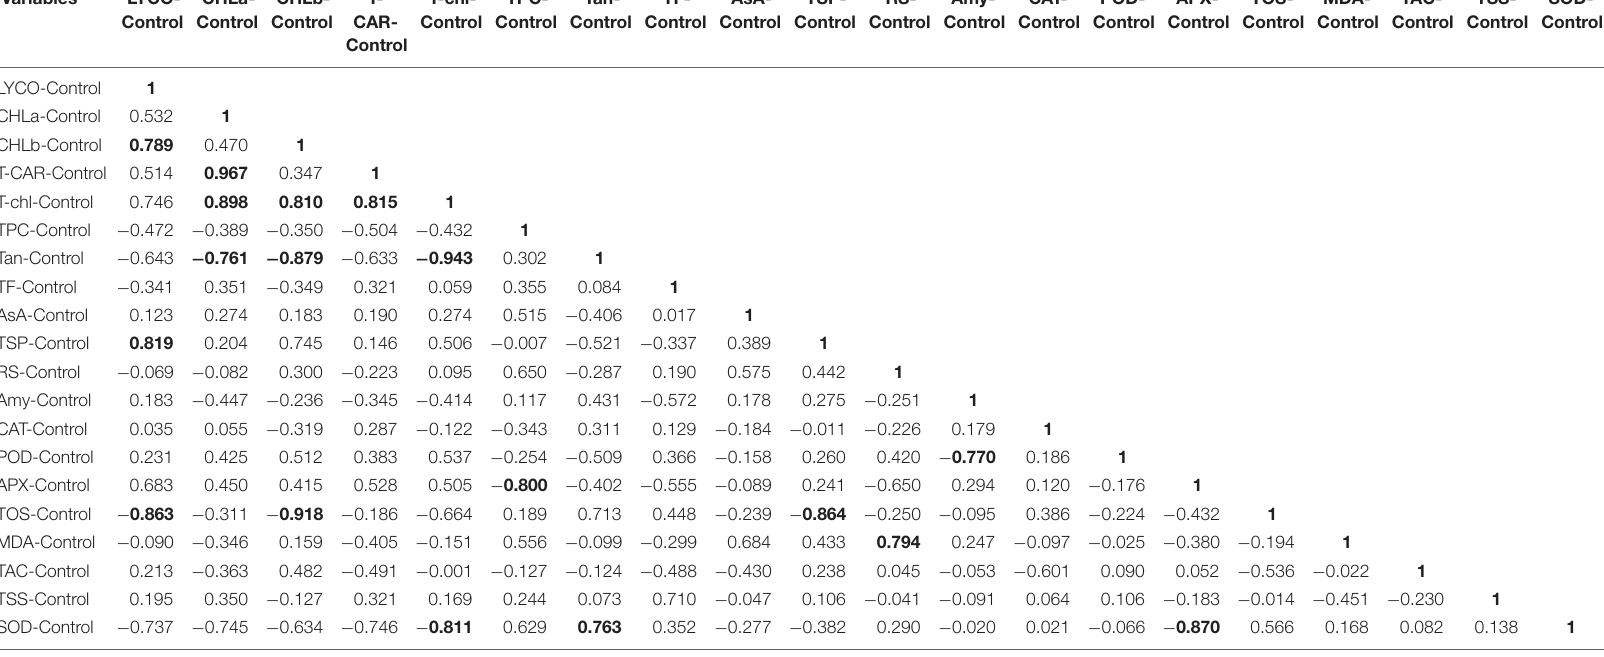
Values in bold are different from 0 with a significance level alpha =